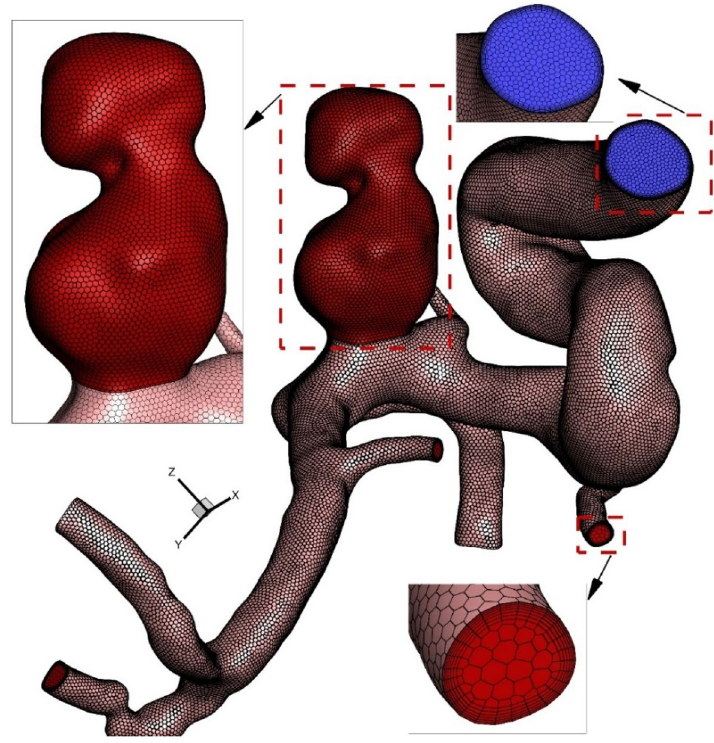
Figure 3. Generated